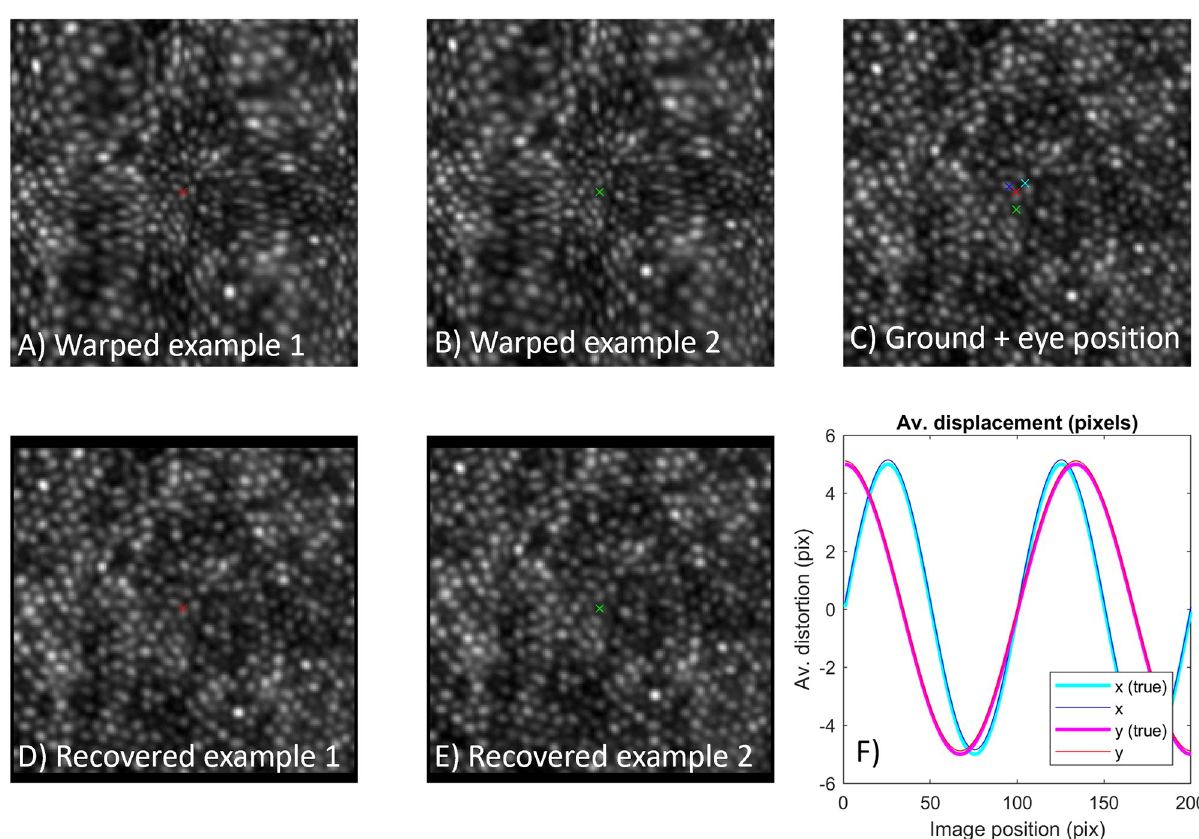
Fig 3. Example correction of static distortion in 2D. Four distorted frames were generated with the eye at different positions corresponding to the coloured crosses. Example imagery is shown (A, B) which appears highly warped compared to the ground truth data (C). Nonetheless, images are recovered with high accuracy (D, E). The profile of recovered distorting functions is plotted (F), showing strong similarity to the true distorting profiles.